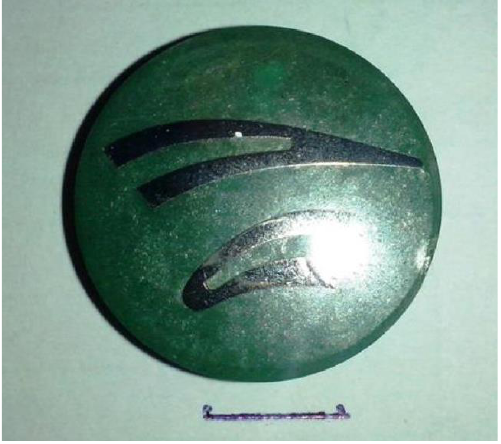
Figure 8. Metallographic specimen of the material of the LPT blade.